Question: What direction does the quantity move in — increasing or decreasing?
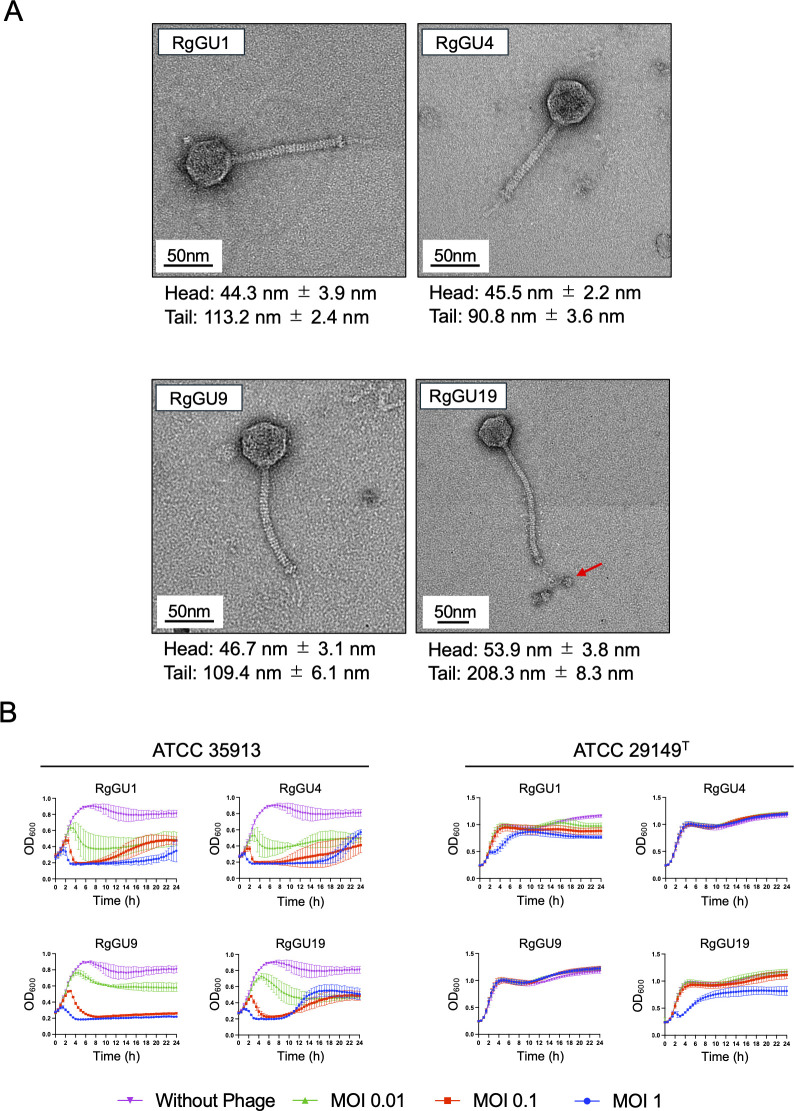
Answer: increasing